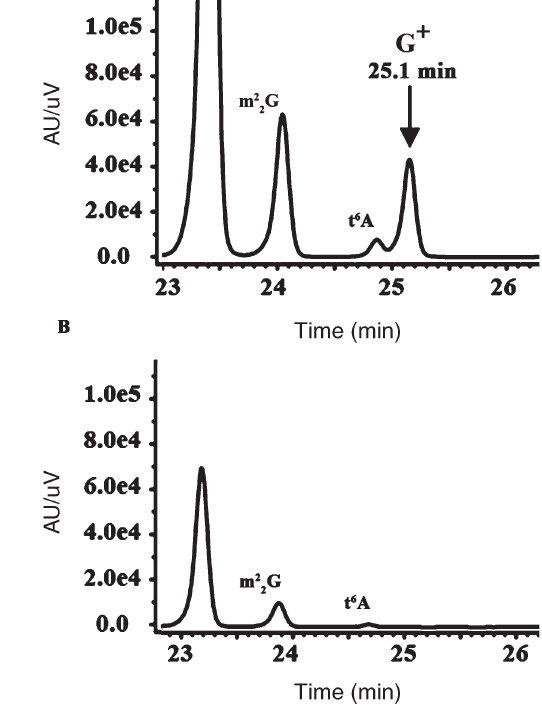
Figure 4. Analysis by LC-MS of tRNA extracted from H. volcanii strains showing the presence or absence of the G + absorbance peak at 254 nm for H26 (A and B) and VDC3242 strains (C). Two additional modification are indicated, m 22 G and t 6 A.